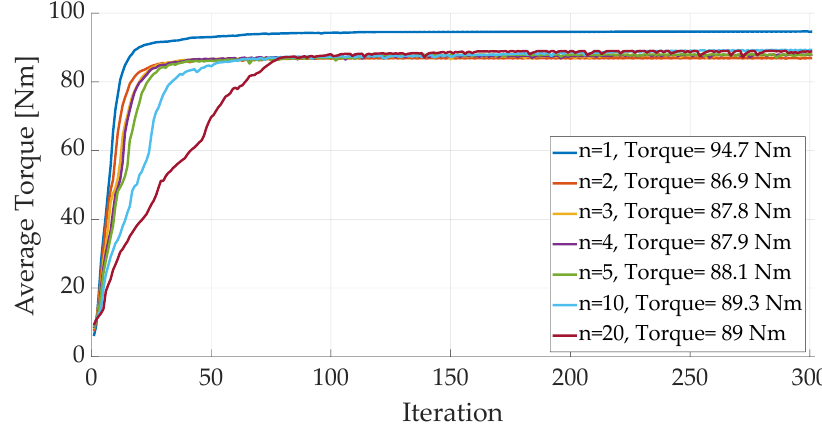
Figure 8. Results of optimizations with different penalization coefficients.